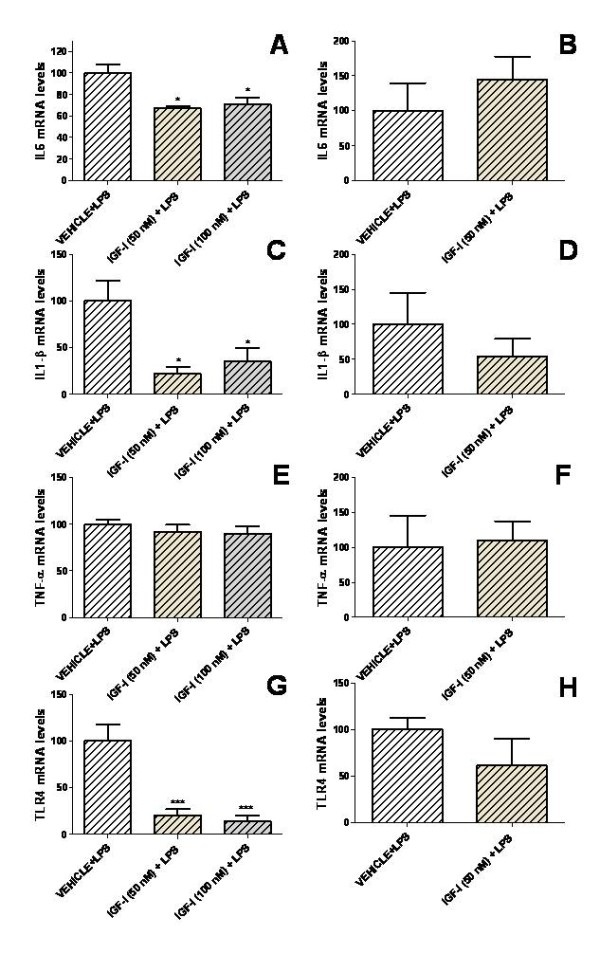
IGF-I decreases the inflammatory response of astrocytes exposed to LPS. mRNA levels of IL6 (A,B), IL-1β (C,D), TNF-α (E,F) and TLR4 (G,H) in astrocytes 24 h (A,C,E,G) or 72 h (B,D,F,H) after the addition of IGF-I (50 or 100 nM) or vehicle only and treated for the last 5 h with LPS. Data are presented as mean ± SEM and are expressed as percentage of control (vehicle + LPS) values. *,***, Significant differences (* P < 0.05; ***P < 0.001) in comparison to the values of cultures treated with vehicle + LPS.